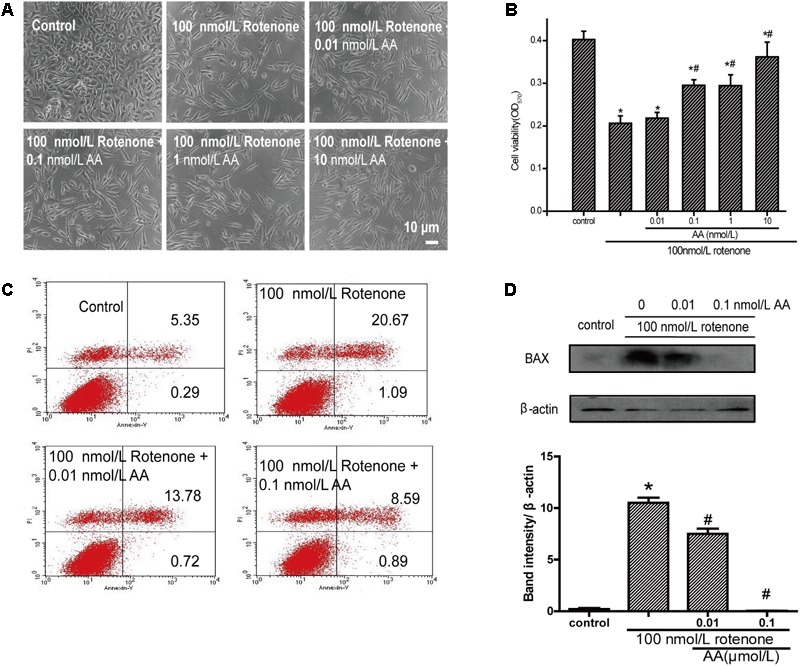
Anti-apoptotic effects of AA in rotenone-induced SH-SY5Y cell damage. (A) Morphology of SH-SY5Y cells after 24 h of treatment with various concentrations of AA after 24 h 100 nM rotenone exposure. Bar: 10 μm. (B) Cell viability of SH-SY5Y cells treated with AA after rotenone-induced cell damage. The data represent means ± SD n = 5. P < 0.05 vs. control group. (C) SH-SY5H cells were treated with AA and rotenone, and apoptosis rates of SH-SY5Y cells were measured by Annexin V/PI. (D) Translation levels of BAX were measured by western blot. Data are expressed as means ± SD, n = 3. ∗p < 0.01 vs. control group, #p < 0.01 vs. rotenone group.